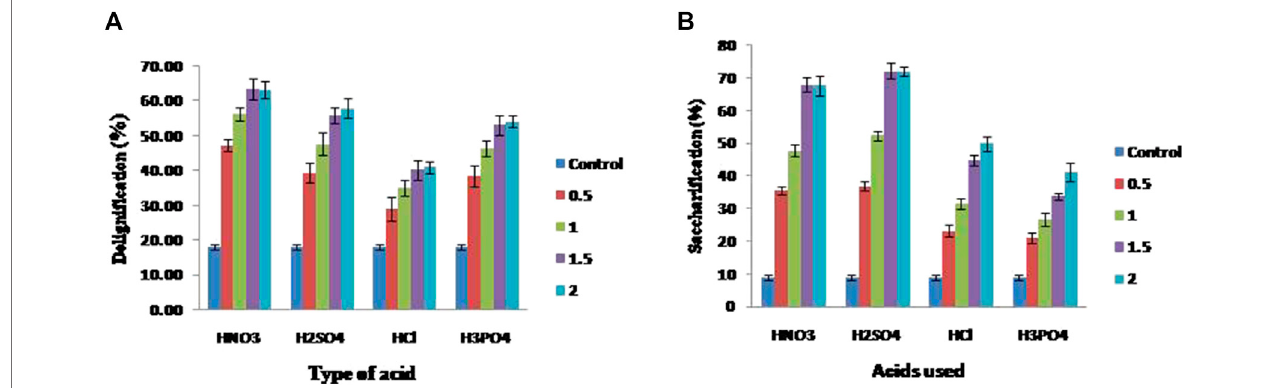
FIGURE 3 | Effect of different acids on deligni fi cation and sacchari fi cation of corn cobs (A) deligni fi cation percentage of corn cobs and (B) xylose released during the sacchari fi cation.